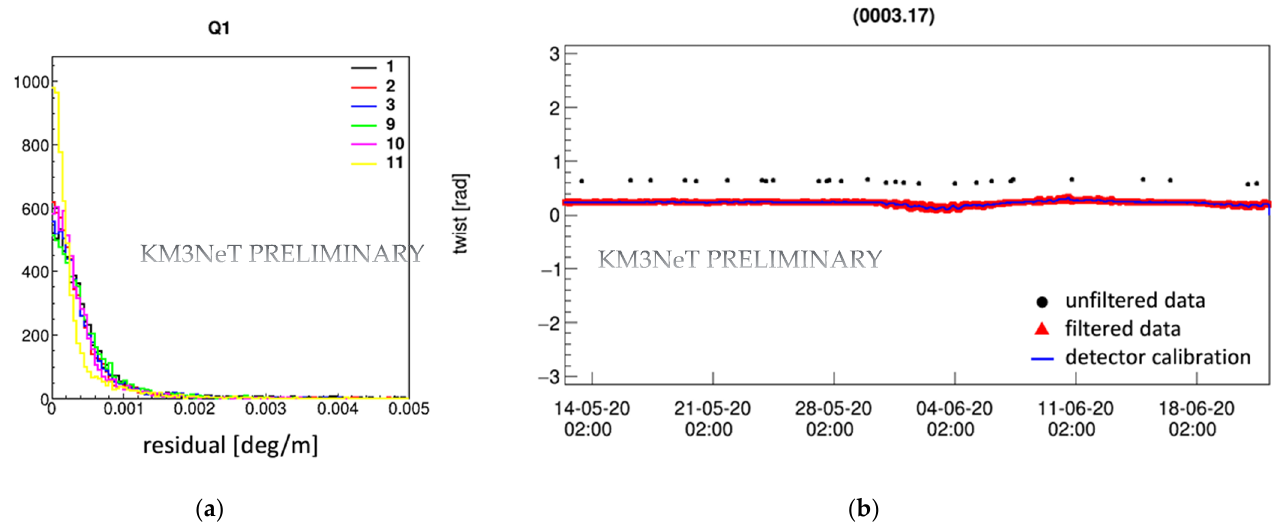
Figure 3. Dynamic orientation calibration for Digital Compasses in ORCA detector: ( a ) Q 1 (twist) residuals (color refers to the DU); ( b ) Q 1 as a function of time (DU3F17).